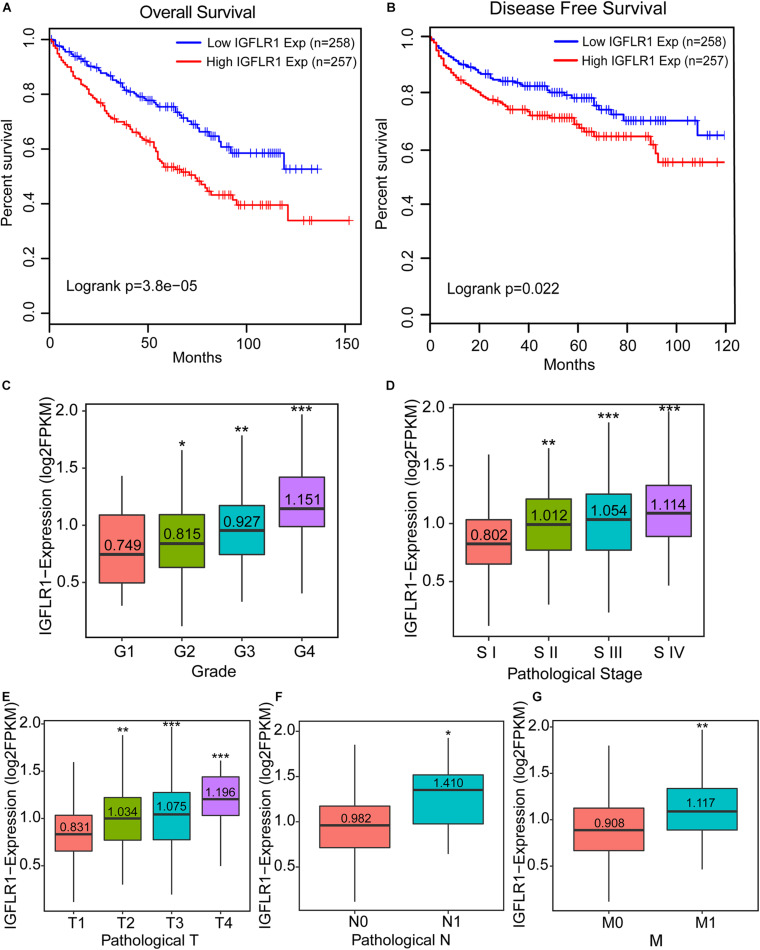
Prognostic potential of IGFLR1 in ccRCC. (A,B) Survival curves of OS and DFS in ccRCC (n = 515). We used log-rank test to analyze IGFLR1 expression in ccRCC with 50% as cutoff value to generate survival curves including OS and DFS. (C–G) Boxplots show the distribution of IGFLR1 expression level of ccRCC tumor samples stratified by pathologic stage, T, N, M and histological grade. All the advanced tumors were compared with stage1, Grade1, N0, T1, and M0 tumors. OS: overall survival; DFS: disease free survival. (Median of expression level were compared using independent group t tests when the data were normally distributed; otherwise, the Wilcoxon test was used (n.s.: not significant, *p < 0.05, **p < 0.01, ***p < 0.001).